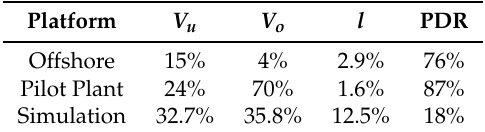
Table 2. Benchmark PID control solution’s evaluation data. Maximal peak-to-peak oscillating amplitude of the valves and the maximum percentile error of l and the PDR.